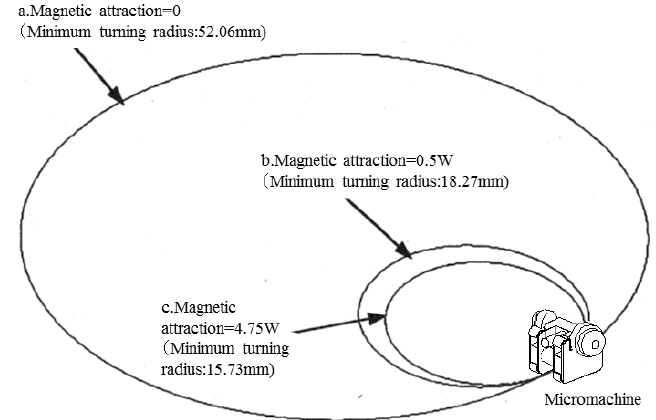
Figure 10. Trajectories (influence of the magnitude of magnetic attraction). a : The driving and driven wheels had no magnetic attraction. b : Each driving wheel had a magnetic attraction of 0.5 W, and the driven wheels had no magnetic attraction. c : Each driving wheel had a magnetic attraction of 4.75 W, and the driven wheels had no magnetic attraction.